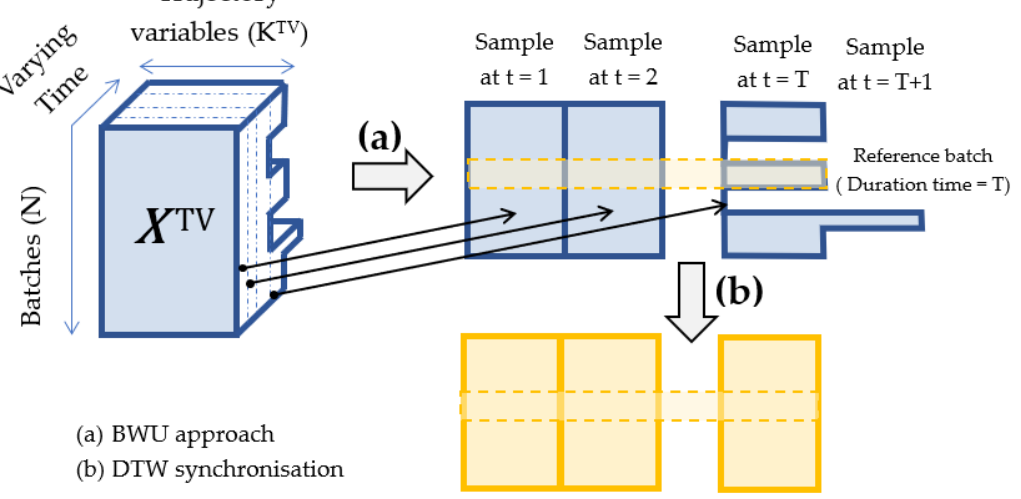
Figure 2. ( a ) Batchwise unfolding (BWU) approach and ( b ) dynamic time warping (DTW) synchronization of the 3D (cid:2180) (cid:3021)(cid:3023) . Note that, once (cid:2180) (cid:3021)(cid:3023) is unfolded and synchronized as seen in Figure 2, it is concatenated with (cid:2180) (cid:3020)(cid:3023) , resulting in the matrix (cid:2180) to be used in the PCA or PLS